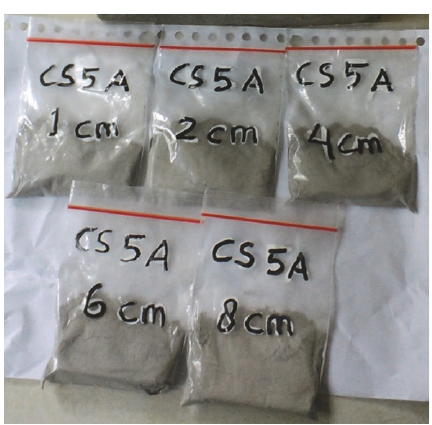
Figure 5: The concrete powder obtained by drilling the concrete specimen with a quality of 30